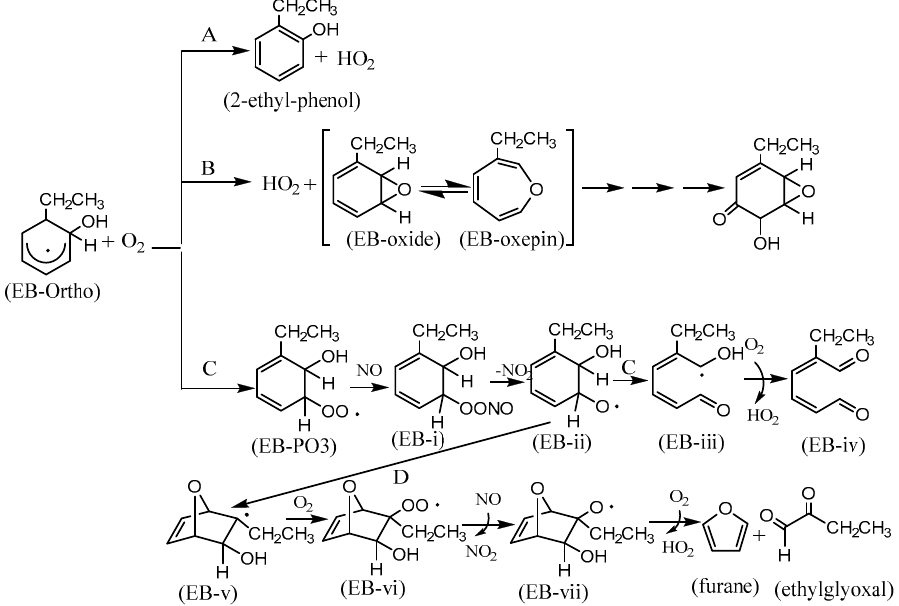
Figure 1. Three suggested pathways of EB-Ortho with O 2